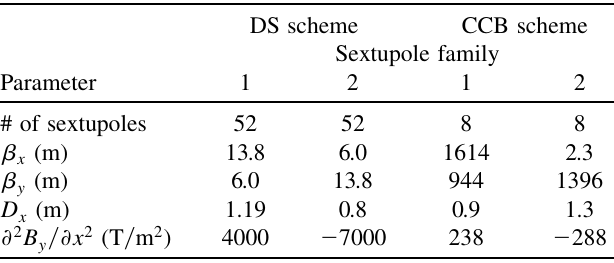
TABLE III. Comparison of the optical functions at the sextu- pole locations and of the sextupole strengths @ 2 B y =@x 2 for 60 GeV =c protons in cases of the DS and CCB-based linear chromaticity correction